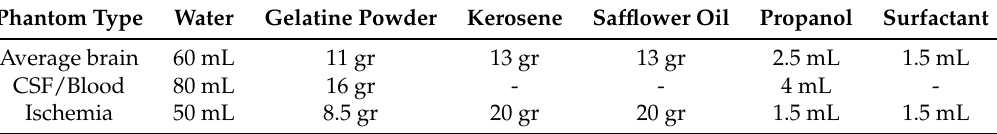
Figure 2. Dielectric properties of the fabricated tissue mimicking phantoms relative to reference values taken from [25] (to the authors’ knowledge, there is no literature regarding the dielectric properties of ischaemia in a wide frequency range). Same type of tissues are presented with the same colour. Table 1. Concentrations of materials used for 100 ml of tissue mimicking